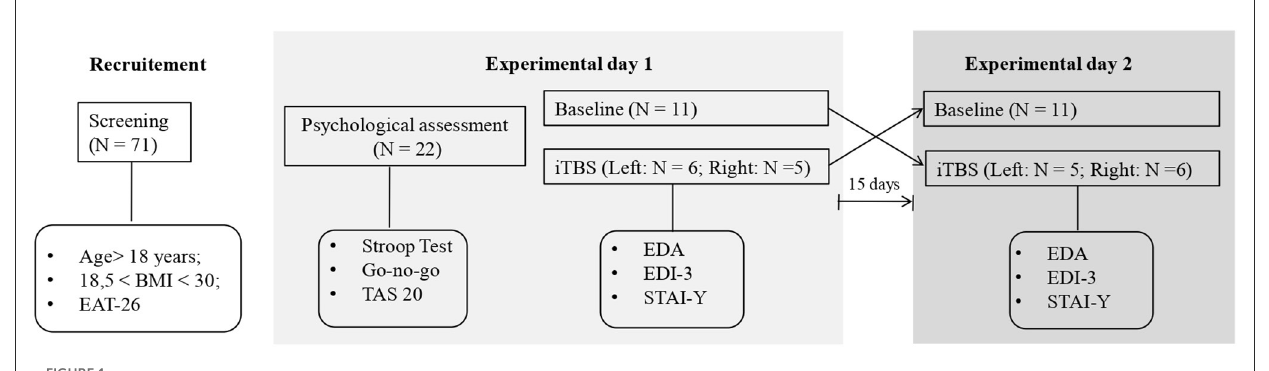
FIGURE1 Schematic diagram of the experimental procedure.